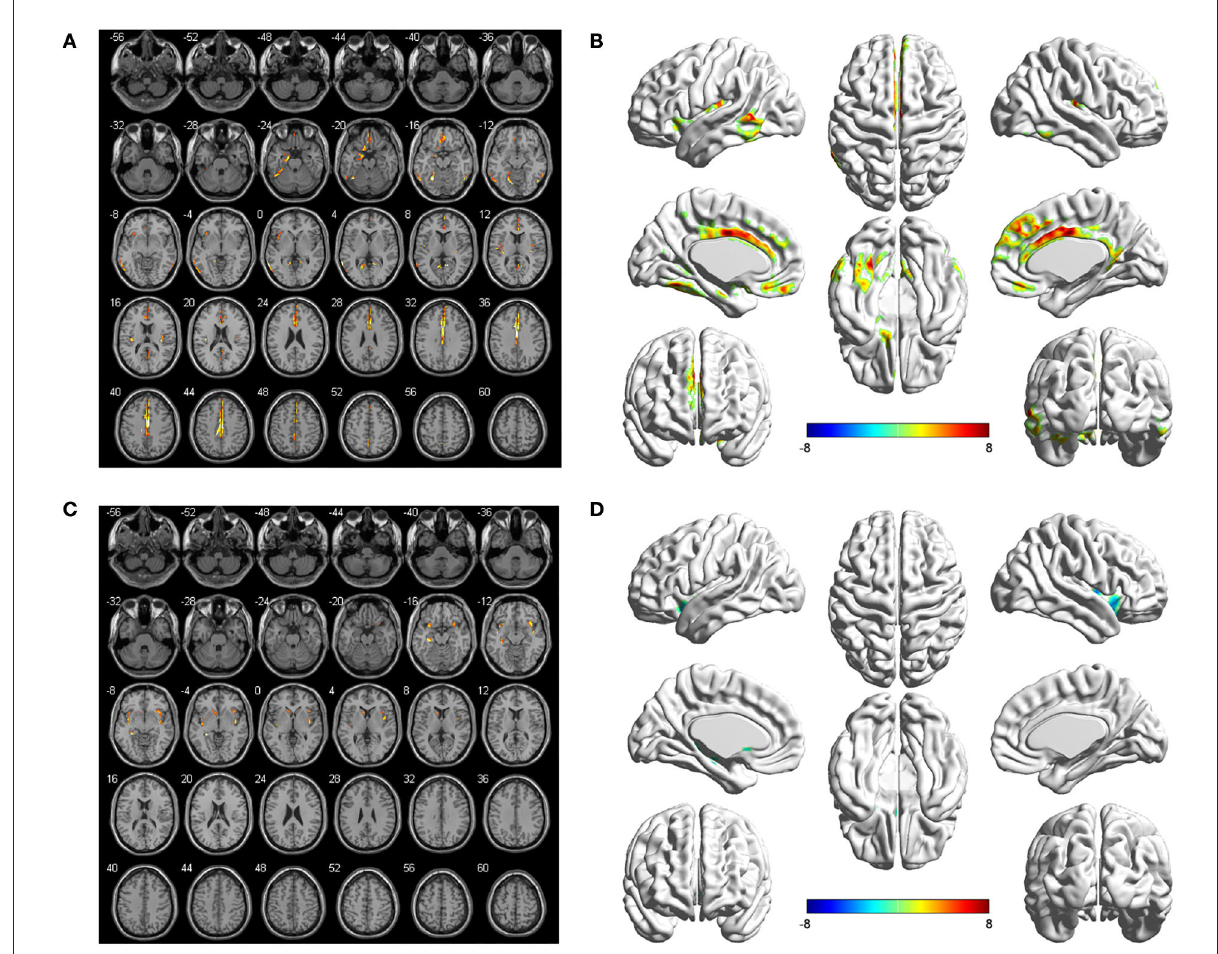
FIGURE3 Differences in the right hippocampal connectivity between patients with ruptured ACoA aneurysm and healthy controls. Compared with the control group, brain regions labeling with color indicate decreased (upper panel) or increased functional connectivity (lower panel) in patients with ruptured ACoA aneurysm. Results were displayed in 2D (A,C) and 3D (B,D) , respectively. The displaying threshold was set to p < 0.05, false discovery rate corrected, and cluster size > 50. Details of abnormal connectivity regions are shown in Table 2. ACoA, anterior communicating